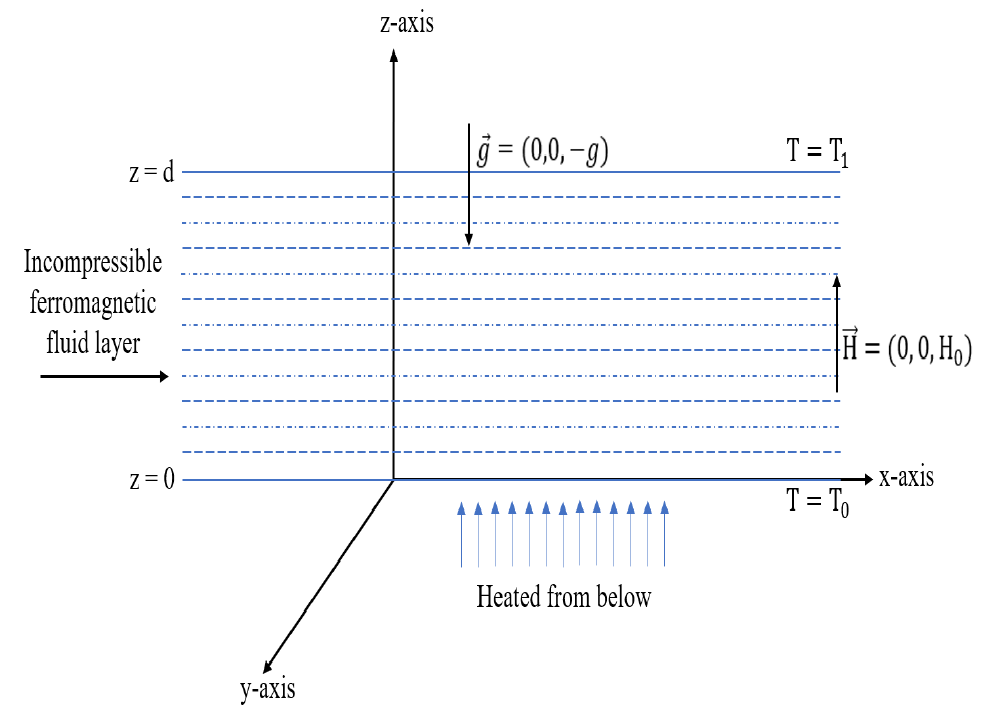
Figure 1. Geometrical